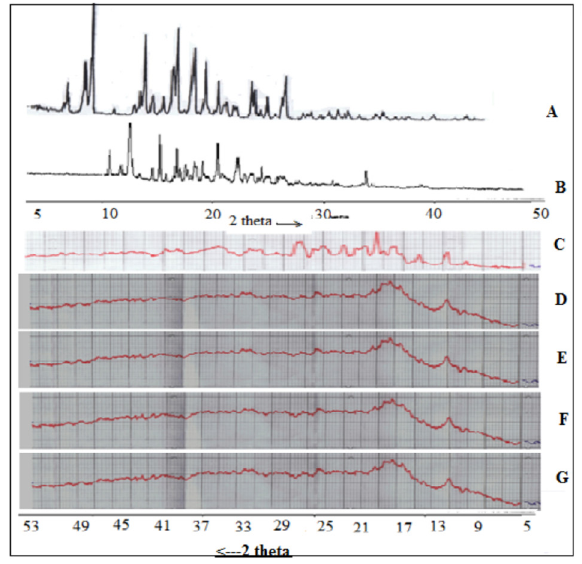
FIGURE 4 - X-ray diffraction studies. (Kn) (4d), co-evaporation method (4e), co-grounding (4f),